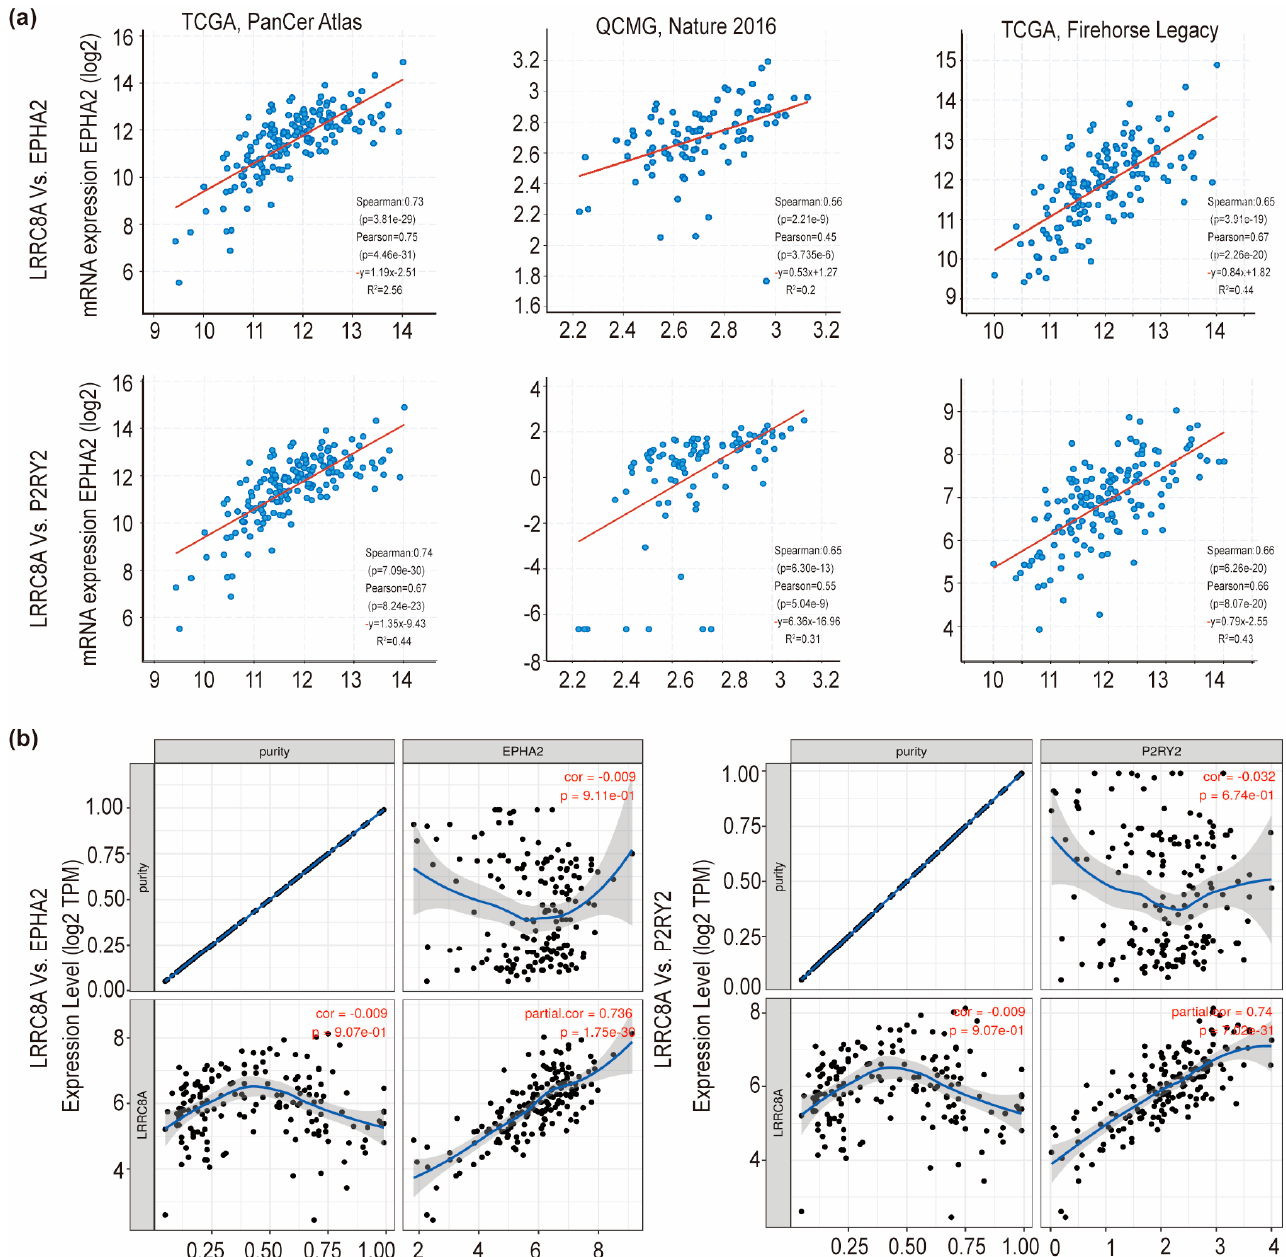
Figure 4. Correlation analysis of LRRC8A with P2RY2 and EPHA2 in PAAD. ( a ) LRRC8A showed a positive correlation with P2RY2 and EPHA2 in cBioPortal; ( b ) LRRC8A showed a positive correlation with P2RY2 and EPHA2 in